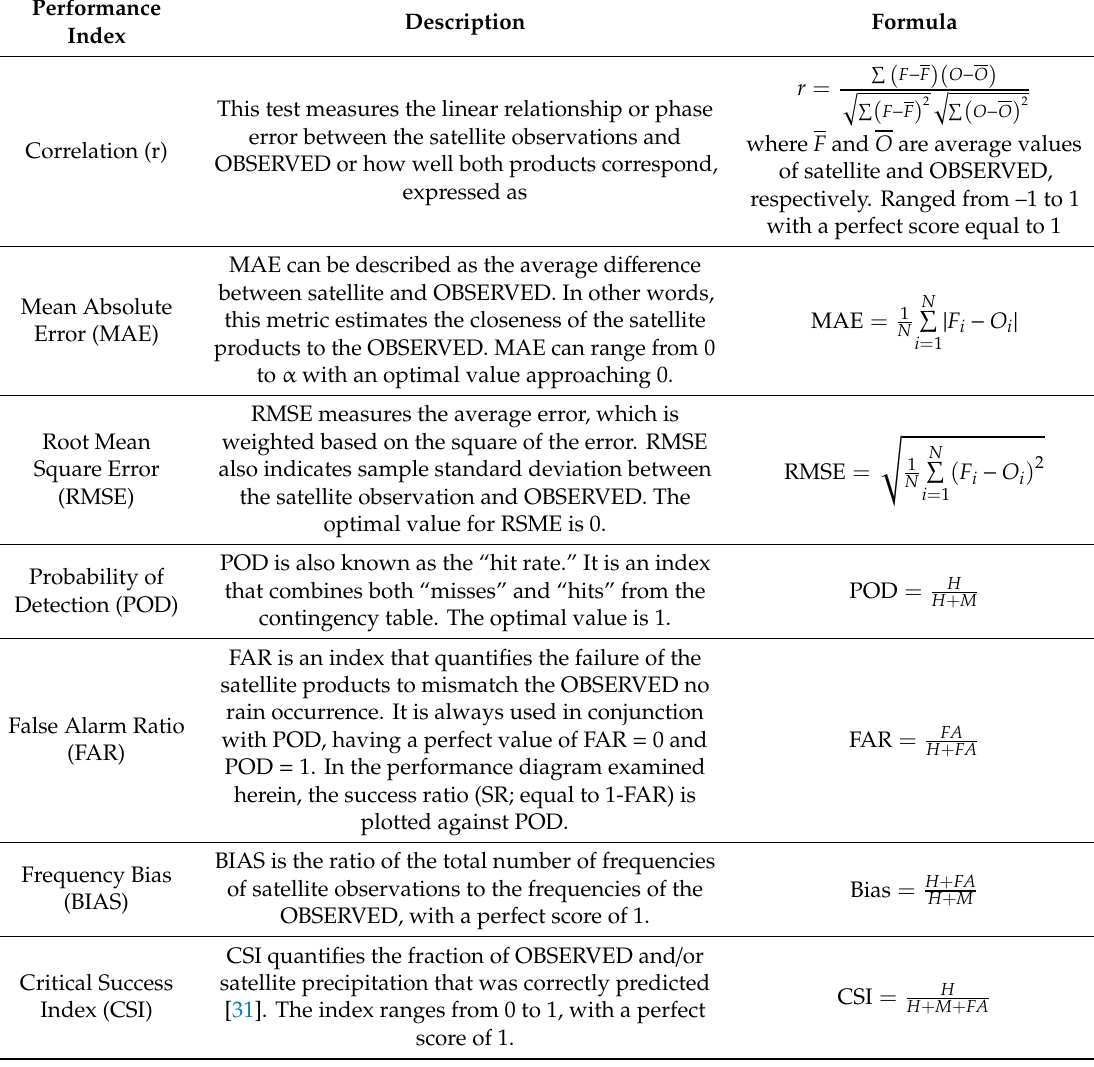
Table 3. Continuous and categorical verification metrics for TRMM and GPM satellite